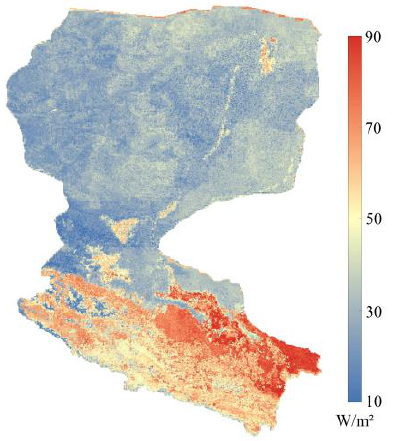
Figure 4. Scatterplots of the five transfer learning models over the test set.